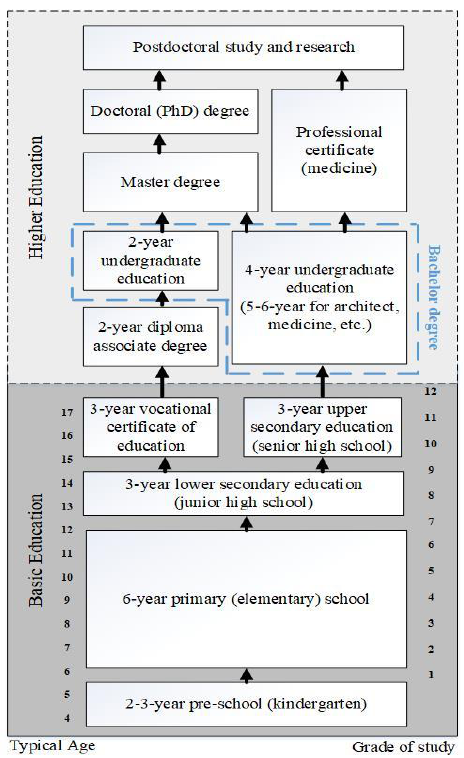
Fig. 1. Thai education